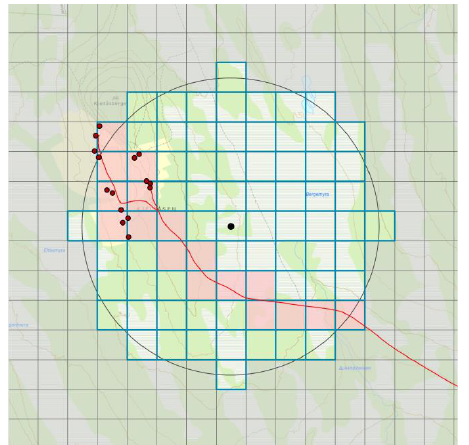
Figure 1. The calculation of the buildings and roads (BI) component of the LUI by focal statistics applied to a 100 m grid. The central 100 × 100 m grid cell for which the index is calculated is indicated by a black dot. The value of the BI index is obtained as the count of 100 × 100 m grid cells (pink squares) in the neighborhood circle with a radius of 500 m, in which buildings (red dots) and roads (red line) are present. In the neighborhood the circle is represented by 81 cells. The underlying map is from Kjeltåsen, Innlandet County, 11.137 ◦ E, 61.000 ◦ N (https://www.geonorge.no/ (accessed on 10 February 2023)).